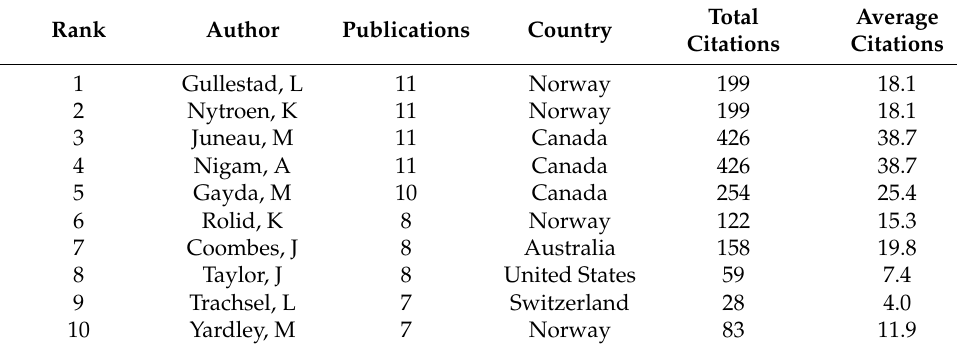
Figure 3. Author collaboration chart. Table 2. Top 10 authors by publications.